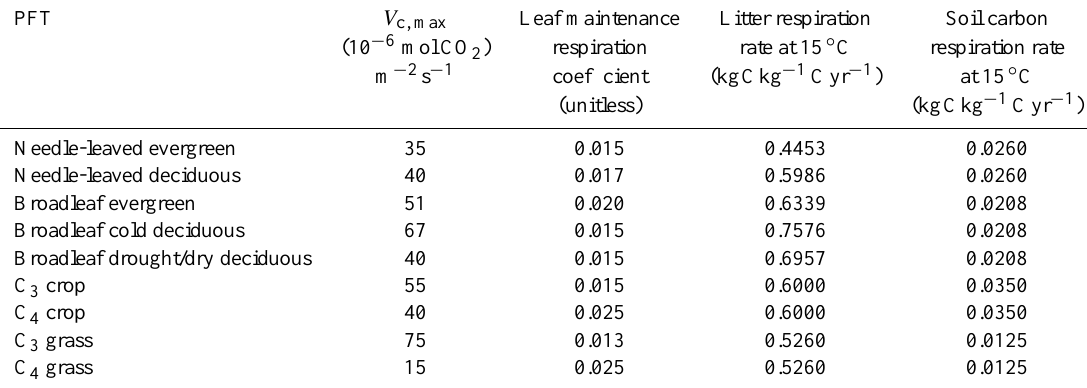
Table A1. CTEM parameter values updated in v 1.2 over v 1.0 (Arora and Boer, 2005) of maximum rate of carboxylation by the enzyme Rubisco, V c, max (Rogers, 2013), leaf maintenance respiration, and litter and soil carbon respiration rate. PFT V c, max Leaf maintenance Litter